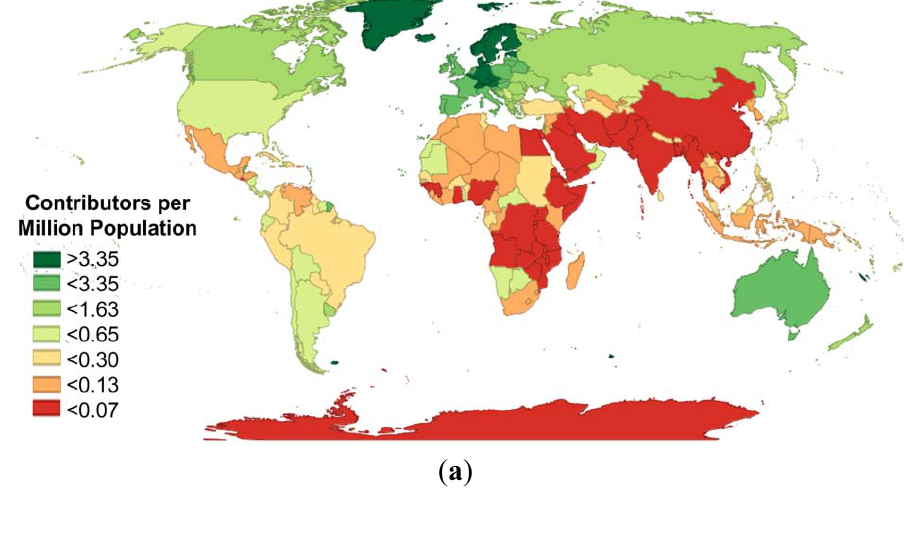
Figure 4. Distribution of active OSM contributors per day and per population in million ( a ) and per area (1000 km 2 ) ( b ) (1 August–31 October